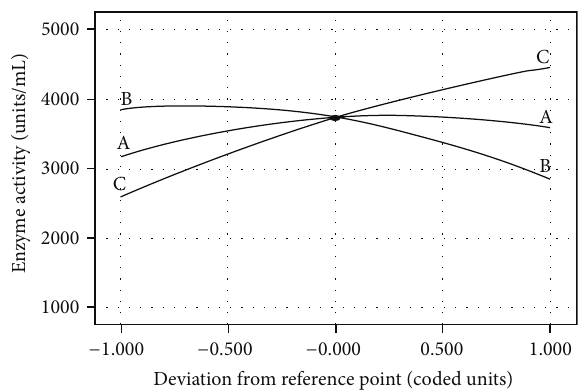
Figure 4: Perturbation graph summarizing the effect of sucrose (A), NaH 2 PO 4 (B),andmoisture(C)onfibrinolyticenzymesproduction.